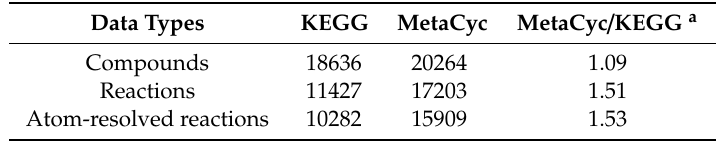
Table 1. KEGG and MetaCyc databases summary.